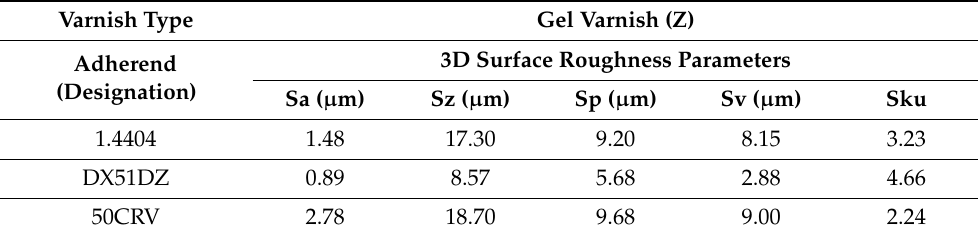
Table 15. Average values of 3D height